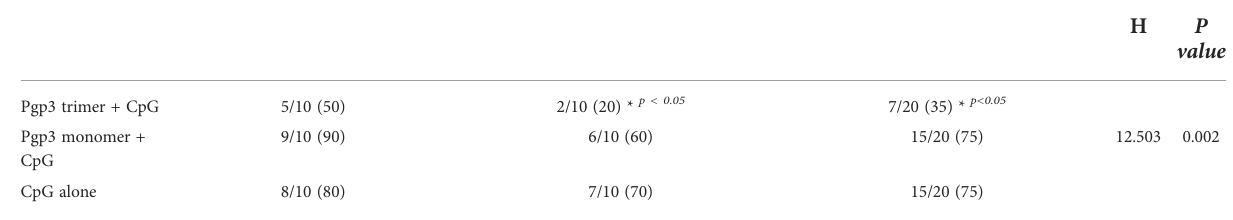
TABLE 2 Hydrosalpinx data in diverse immunization groups. Immunization Number of mice with Number of mice with bilateral group hydrosalpinx/total mice (%) hydrosalpinx/total mice (%) a a